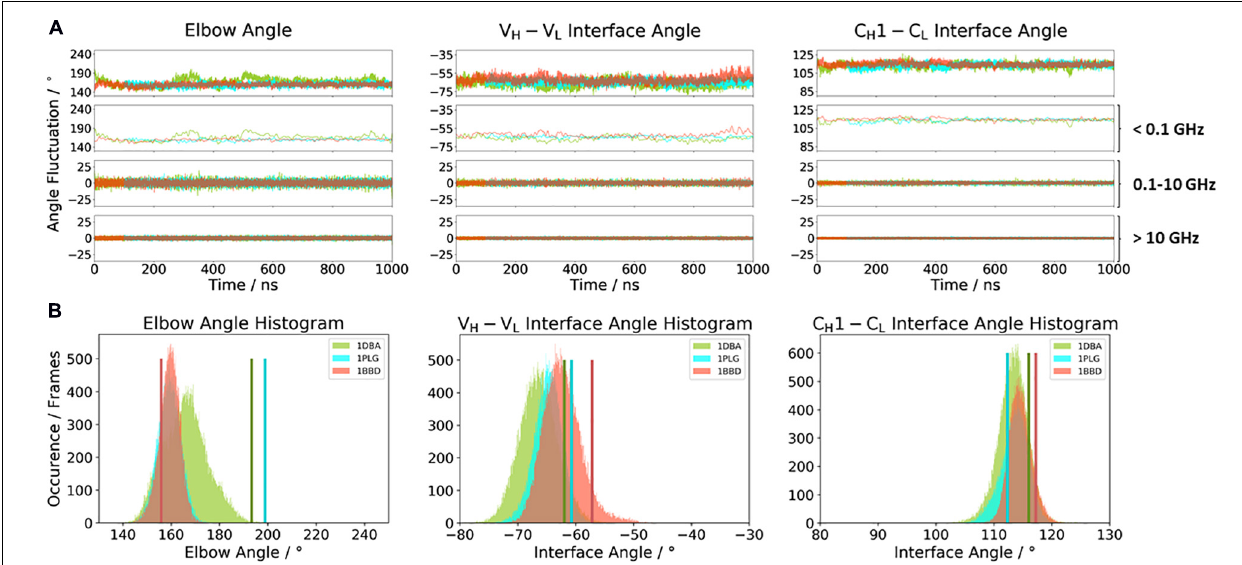
FIGURE 3 | (A) Comparison of the three κ light chain antibodies, which also show a big spread in the elbow angle in the crystal structures. The specific anti-progesterone antibody DB3 (PDB: 1DBA) is colored in green. The 8F5 antibody (PDB: 1BBD) is colored in red, and the X-ray structure of the murine antibody which has a high specificity toward α -(2 → 8)-linked sialic acid polymers (PDB: 1PLG) is colored light blue. Additionally, the FFT of the respective distributions are displayed, showing the angle variations occurring faster than 1 ns, between 0.1 and 10 ns, and slower than 10 ns. (B) Histograms of the respective interface and elbow angle distributions, including the respective X-ray structures of all three κ light chain antibodies, which were used as starting structures for molecular dynamics simulations.